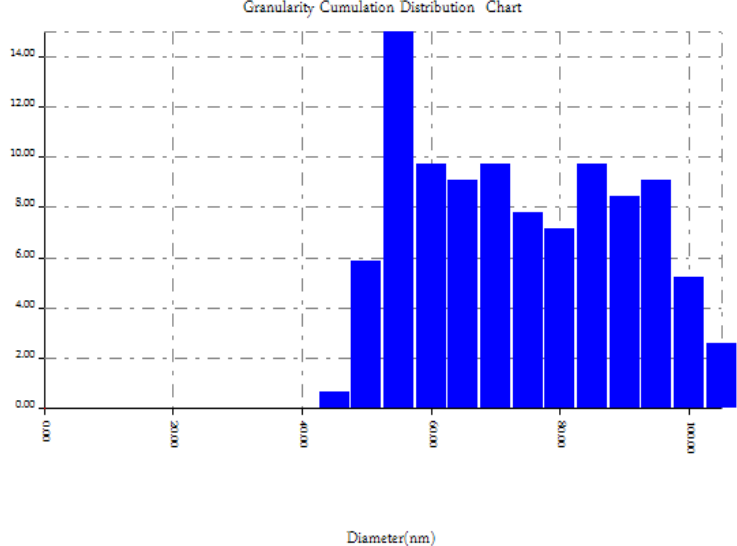
Fig.1: Granularity normal distribution chart for nano Zinc Oxide particl